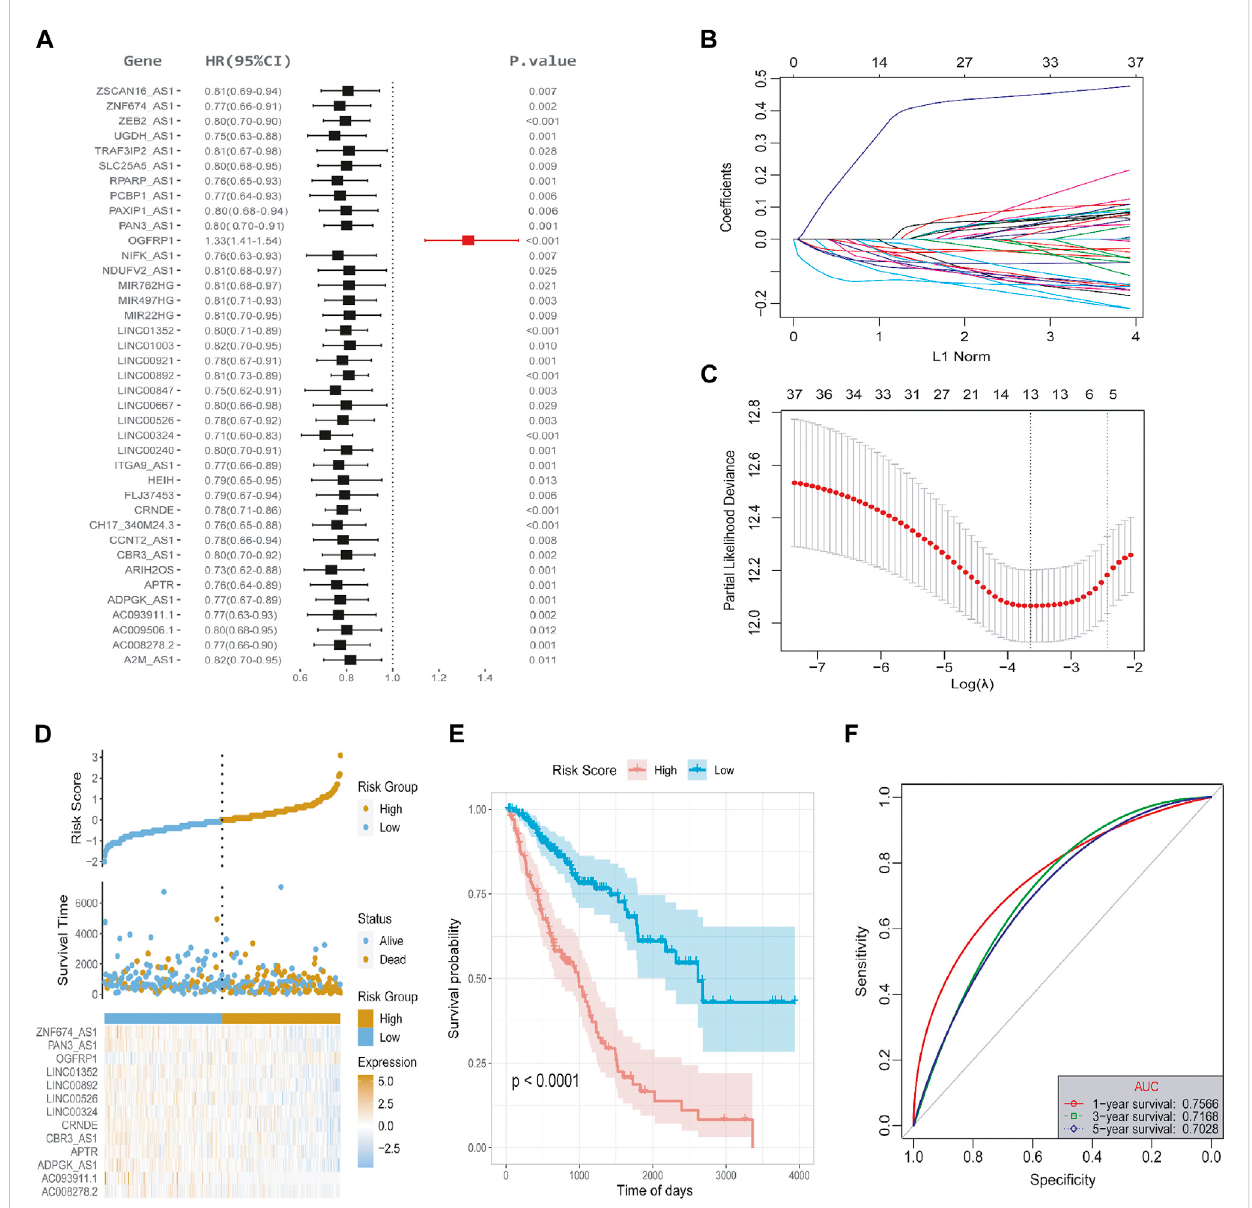
FIGURE 5 Screening oflncRNAsandtheconstructionofriskscoremodel. (A) UnivariateCoxregressionanalysiswasusedtoidentify558candidatelncRNAsin the training set, and 39 lncRNAs were retained. The meaningful threshold was set as p -value < 0.05. (B) The changing trajectory of each independent variable. The horizontal axis represents the log value of the independent variable lambda, and the vertical axis represents the coef fi cient of the independentvariable. (C) Thecon fi denceintervalundereachlambda. (D) Theriskscoredistributiondiagram; (E) SurvivalcurveofLUADpatientswith high- and low-risk scores. (F) ROC curve at 1-, 3-, and 5-